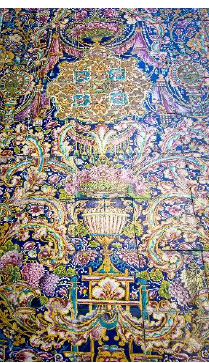
Figure 2. realistic flower pot motif, beside the entrance of